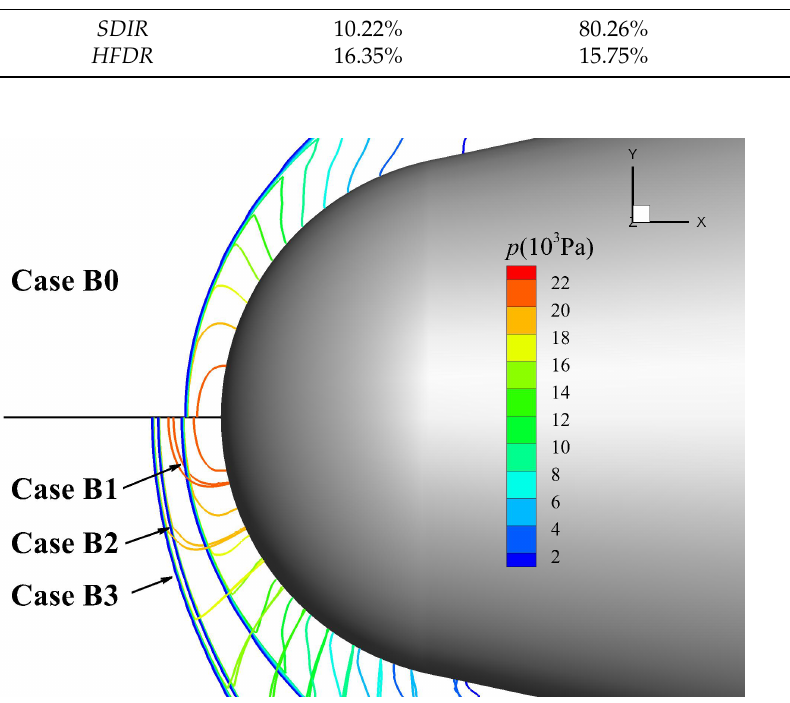
Figure 13. Comparison of shock stand-off